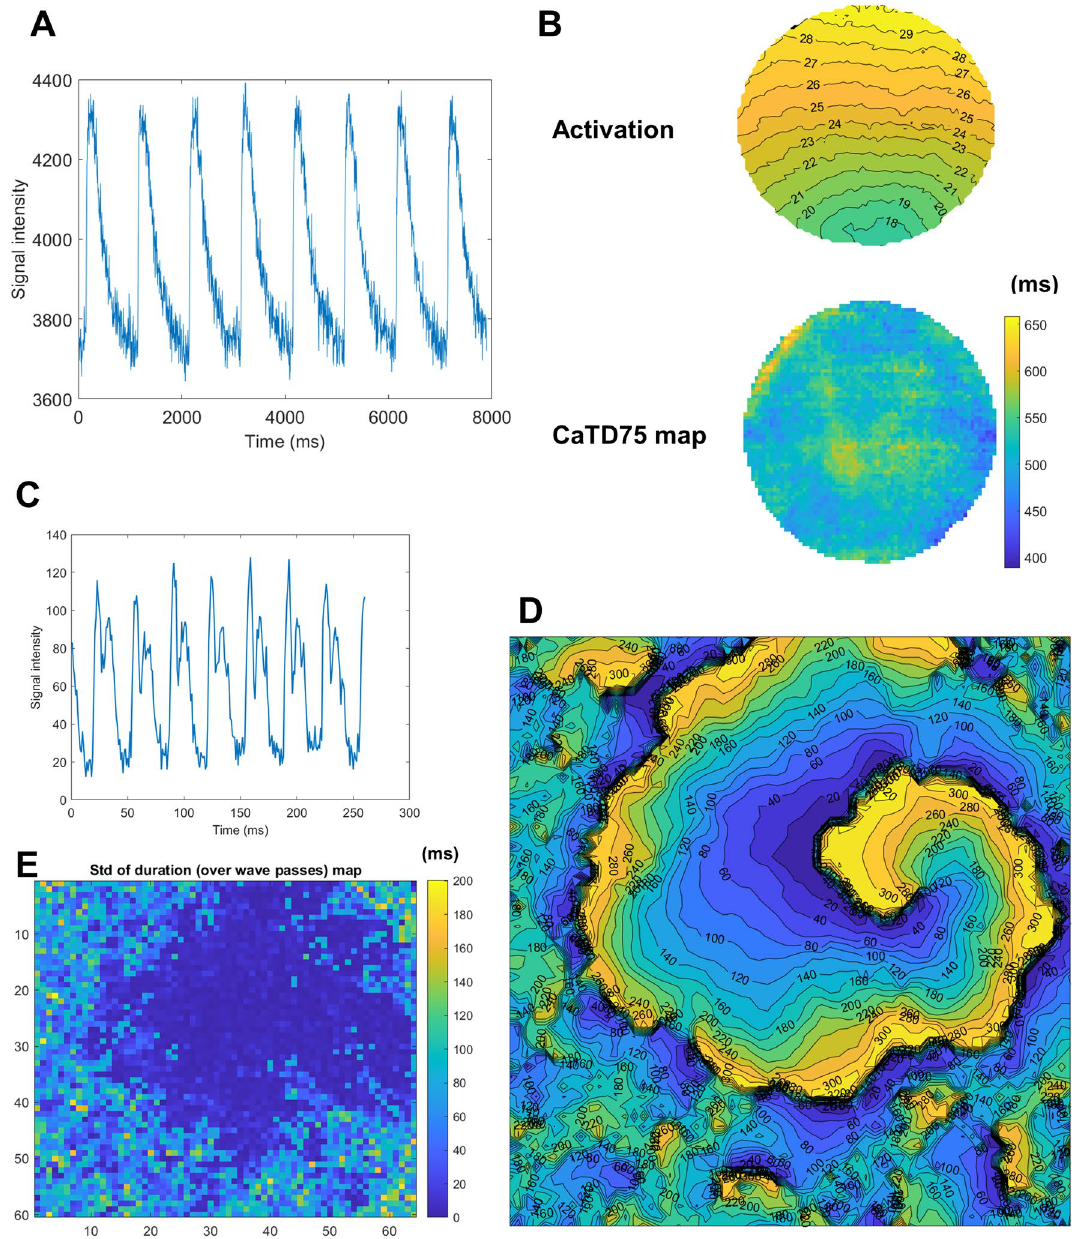
Figure 8. Application of COSMAS to a dish of calcium-imaged monolayer. ( A ) Sample pixel trace (1 Hz pacing). ( B ) Activation map extracted from a culture dish showing calcium-based propagation (top) and a map of CaT duration (CaTD) measured at 80% recovery (bottom). ( C ) Sample trace from a recording obtained off- axis cell culture imaging 19 showing characteristic “double-hump” motion transient morphology corresponding to cellular contraction and relaxation. ( D ) The activation map of a slow-conducting spiral wave imaged using off-axis imaging, with chaotic culture activation around the spiral. ( E ) The map of temporal standard deviation of duration of cellular activation, computed over multiple wave